Question: State the chart type depicted above.
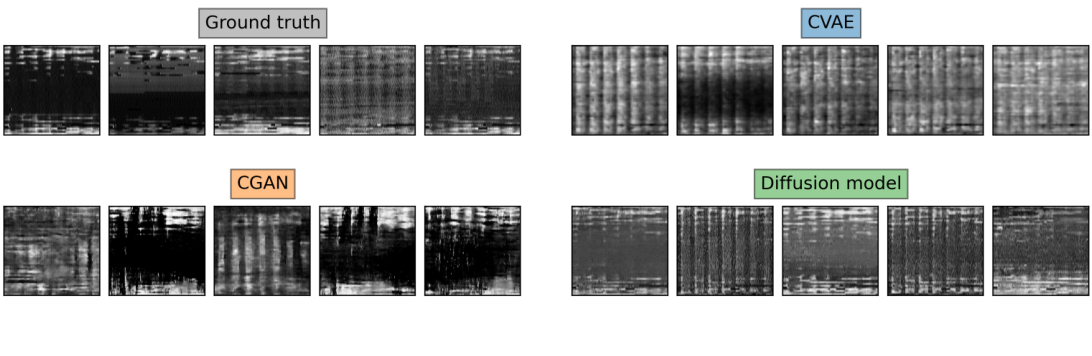
Answer: heatmap